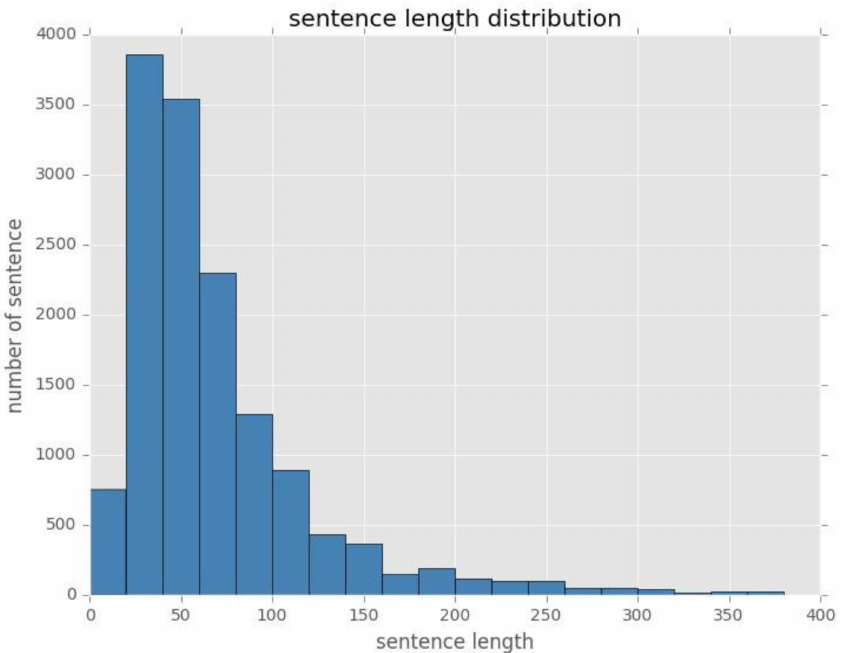
Figure 12. Instance of attention matrix visualization 2.